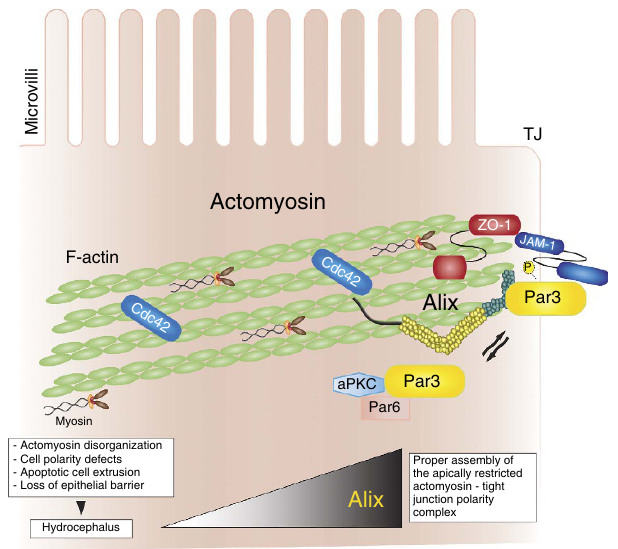
Figure 9 | Model of the mode of action of Alix at the apically restricted actomyosin–tight junction (TJ) complex in the CP. In normal CP cells, Alix by interacting with F-actin, Par 3 and ZO-1 secures the proper assembly and positioning of an actomyosin–TJ complex at the apical sides of adjacent epithelial cells that defines a spatial membrane domain essential for the maintenance of epithelial cell polarity and barrier. Alix ablation in the CP affects the formation/maintenance of the actomyosin–TJ polarity complex with consequent loss of epithelial polarity and barrier, and progressive hydrocephalus.